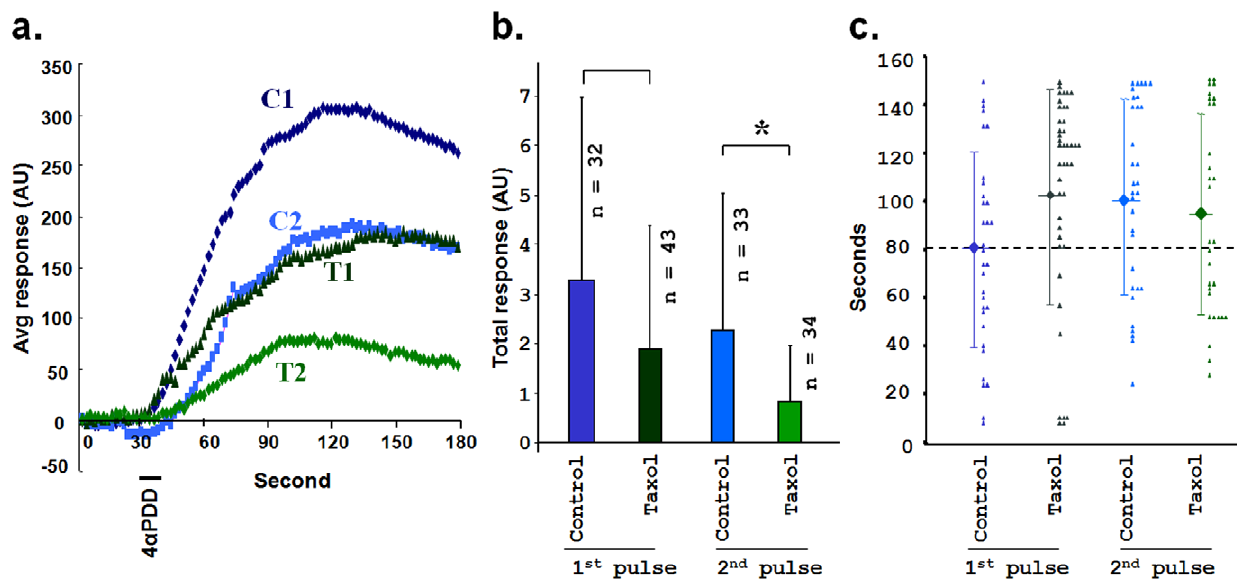
Figure 6. Microtubule cytoskeleton regulates Ca 2 + -influx via TRPV4. a. Taxol (1 m M, 30 minutes) reduces TRPV4-mediated Ca 2 + -influx in Cos7 cells. Shown are the normalized average ratiometric Ca 2 + -influx in arbitrary units (AU). TRPV4 was activated by a pulse (indicated by a black line) of 4 a PDD for 10 sec. The dark blue line (C1) represents average response due to first pulse in control conditions (n=32), the light blue line (C2) represents average response due to second pulse in control conditions (n=32), the blackish green line (T1) represents average response due to first pulse under the influence of Taxol-stabilized microtubules (n=42) and the light green line (T2) represents the average response due to second pulse under the Taxol-stabilized microtubules (n=30). b. Cells with Taxol-stabilized microtubules reveal reductions in total Ca 2 + -influx due to TRPV4 activation. Total Ca 2 + -influx was calculated from the total area appeared by the ratiometric calcium-influx graph (as shown in figure a) for each cell and was calculated by Origin 7G software. At the , 0.05 level, the difference of the population means between 2 nd pulse (untreated and taxol-treated, one sample t-test) is significant (*). The difference in case of 1 st pulse is non-significant. c. Taxol stabilized cells reveal a trend for time delay to reach in maximum response. The time (in seconds) each cell took to reach its maximum response (indicated by filled triangles) was plotted. Times needed during first pulse in control conditions (dark blue), second pulse in control conditions (light blue), first pulse with Taxol (blackish green) and second pulse with Taxol (light green) are indicated. The average values (indicated by filled squares) and the standard deviations are also shown for each condition. The average time differences remain non-significant.